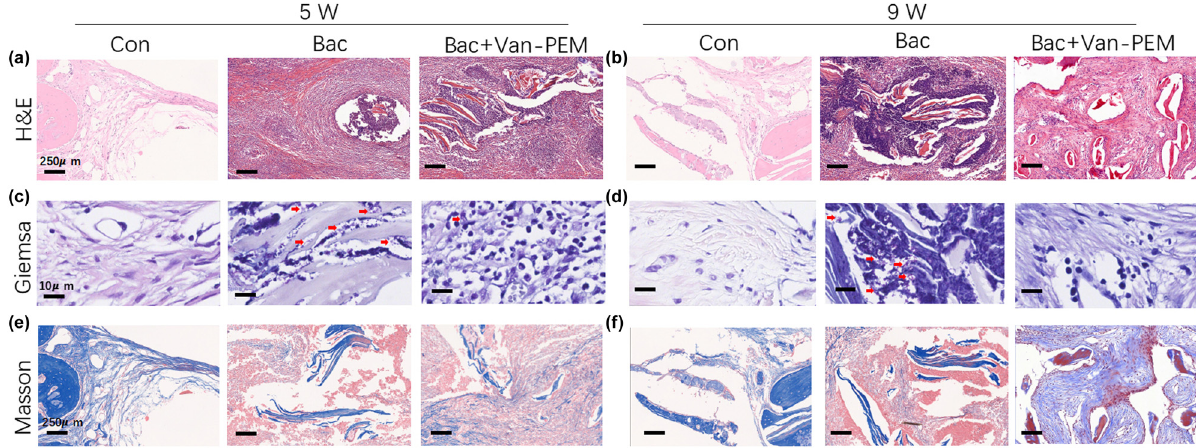
Figure 8: ( a and b ) H&E staining of the skull wounds in the control, bacteria - treated, and Van - PEM groups at weeks 5 and 9. Van - PEM hydrogel treatment can signi fi cantly reduce the in fl ammatory response. ( c and d ) Giemsa staining of each group at the same time points. Van - PEM hydrogel can reduce the number of bacteria in the bone defect site. Red arrows indicate bacteria hidden in tissue. ( e and f ) Masson staining of each group at the same time points. Van - PEM hydrogel treatment promotes collagen